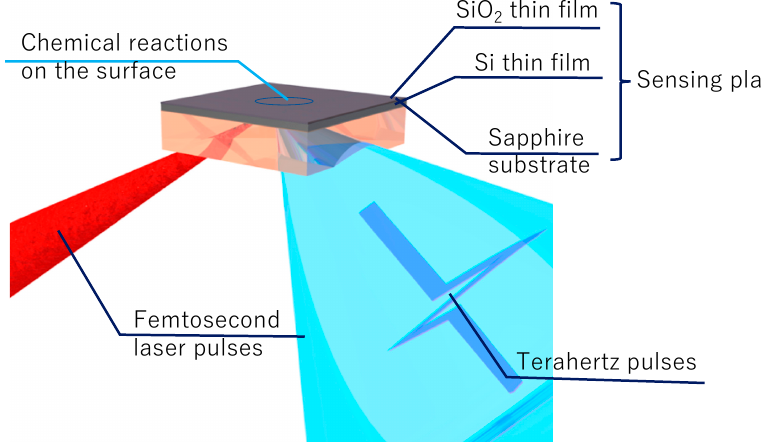
Figure 1. Schematic of the sensing plate. The sensing plate consists of a Si thin film sandwiched between a SiO 2 thin film and a sapphire substrate. Femtosecond laser pulses penetrate the sensing plate, generating THz pulses in the Si thin film. The amplitude of the THz pulses depends on the chemical reactions on the surface of the sensing plate.